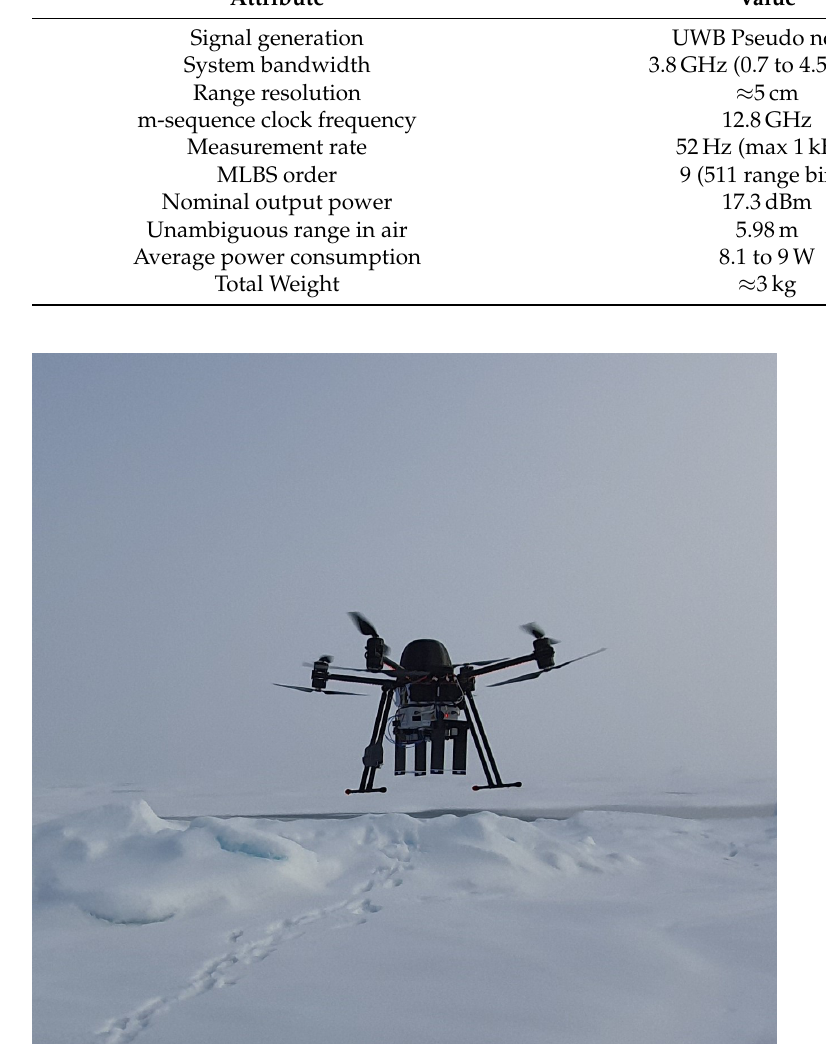
Figure 1. UWiBaSS mounted under the UAV Cryocopter FOX during